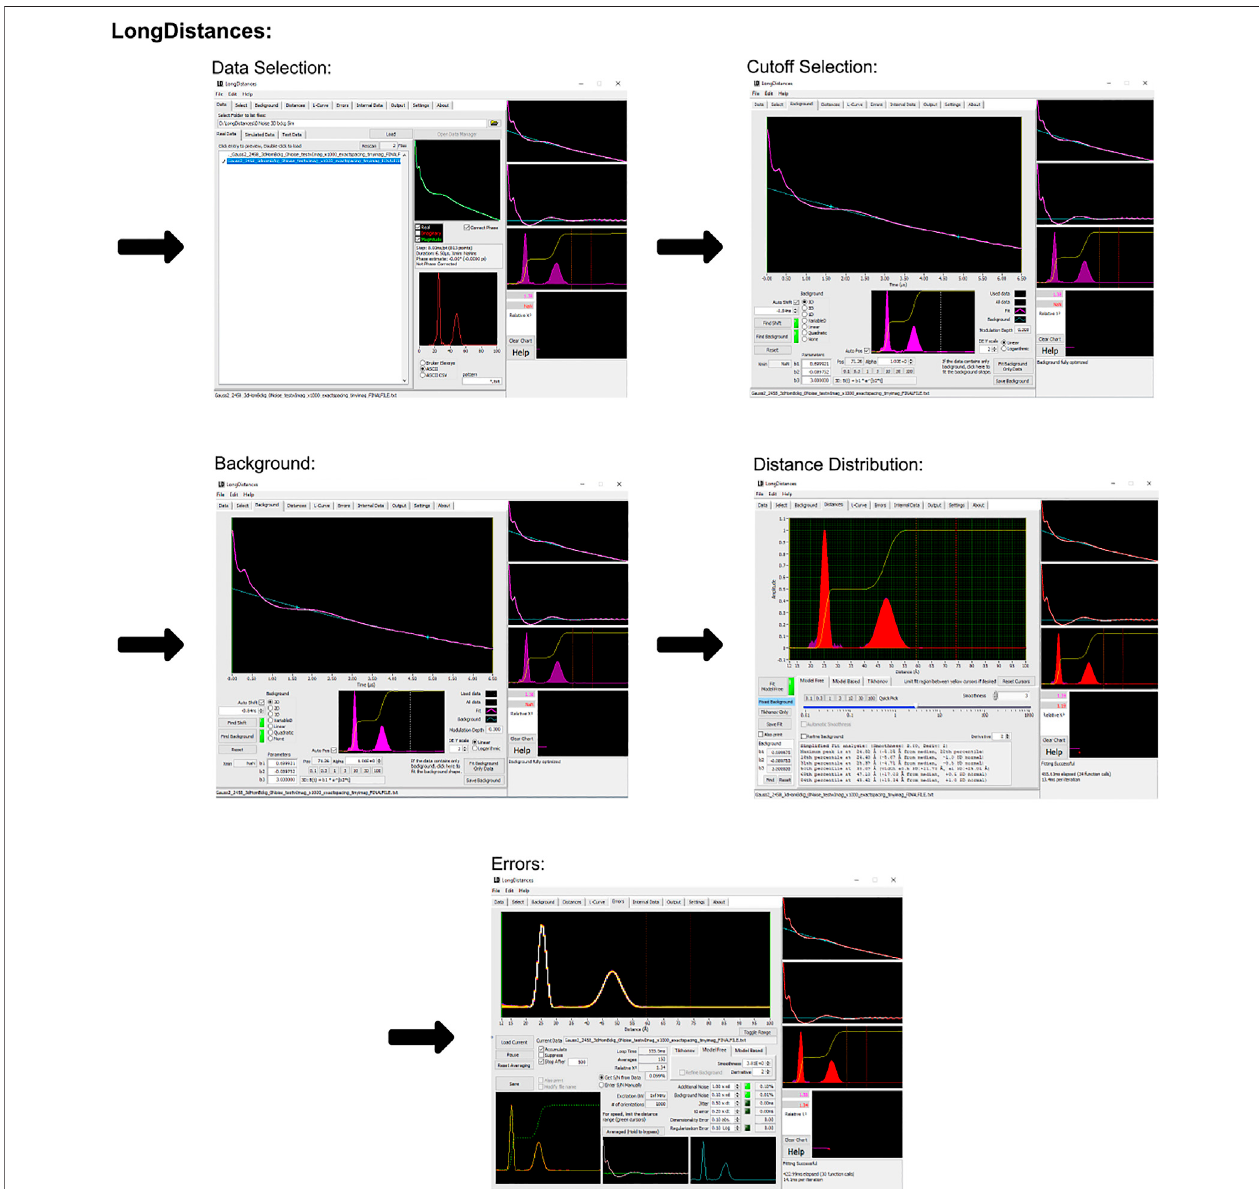
FIGURE 3 | LongDistances work fl ow. The package was developed in LabVIEW and is available as a Windows executable only. Data set shown is simulated noiseless, which was an ASCII fi le. For users using Elexsys type fi les, “ Bruker Elexsys ” should be selected in panel one in place of “ ASCII ” .